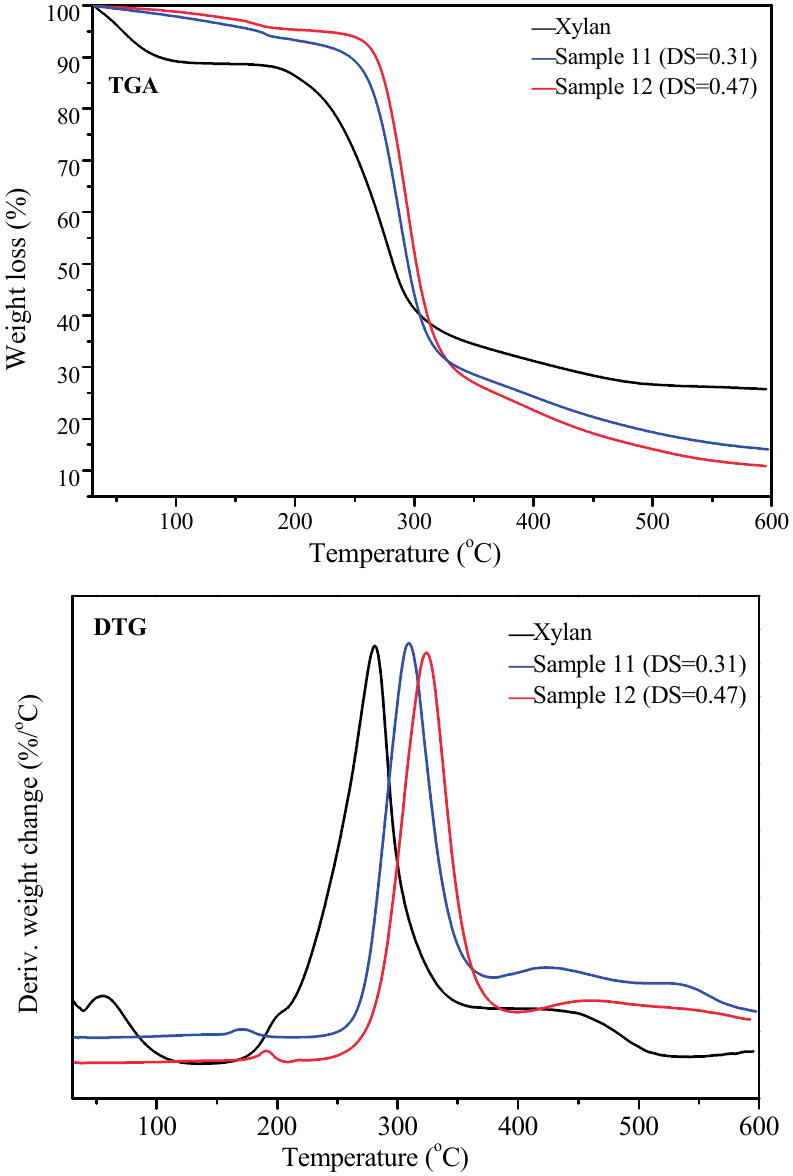
Figure 5. TGA/DTG curves of unmodified xylan and xylan- g -PPC copolymers sample 11 (DS = 0.31) and sample 12 (DS =